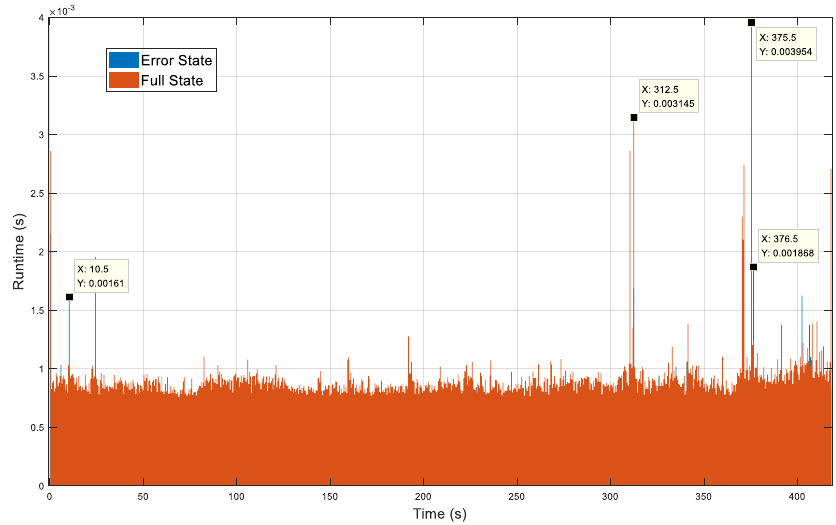
Figure 8. The filtering time of the error-state and full-state EKFs. Table 2. Filtering time comparison.